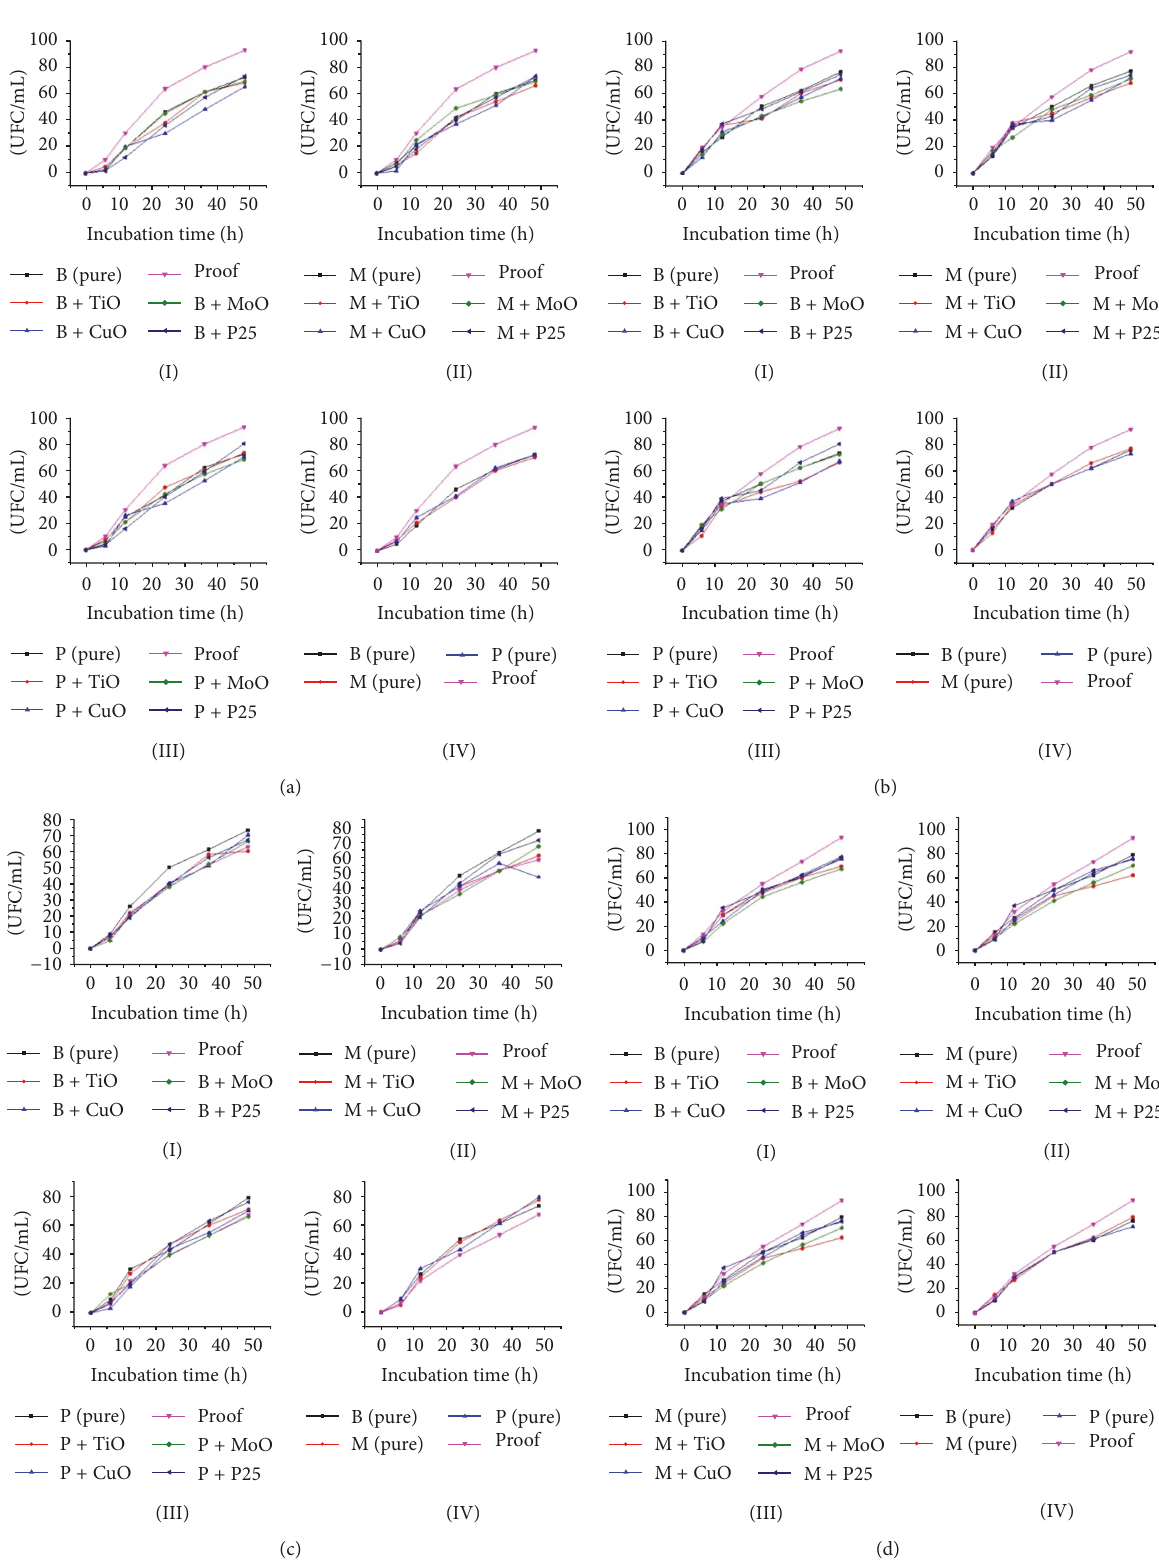
Figure 1: Antibiogram of clinical isolates: (a) refers to C. albicans ; (b) refers to E. coli ; (c) refers to S. aureus ; and (d) refers to P. aeruginosa microorganisms